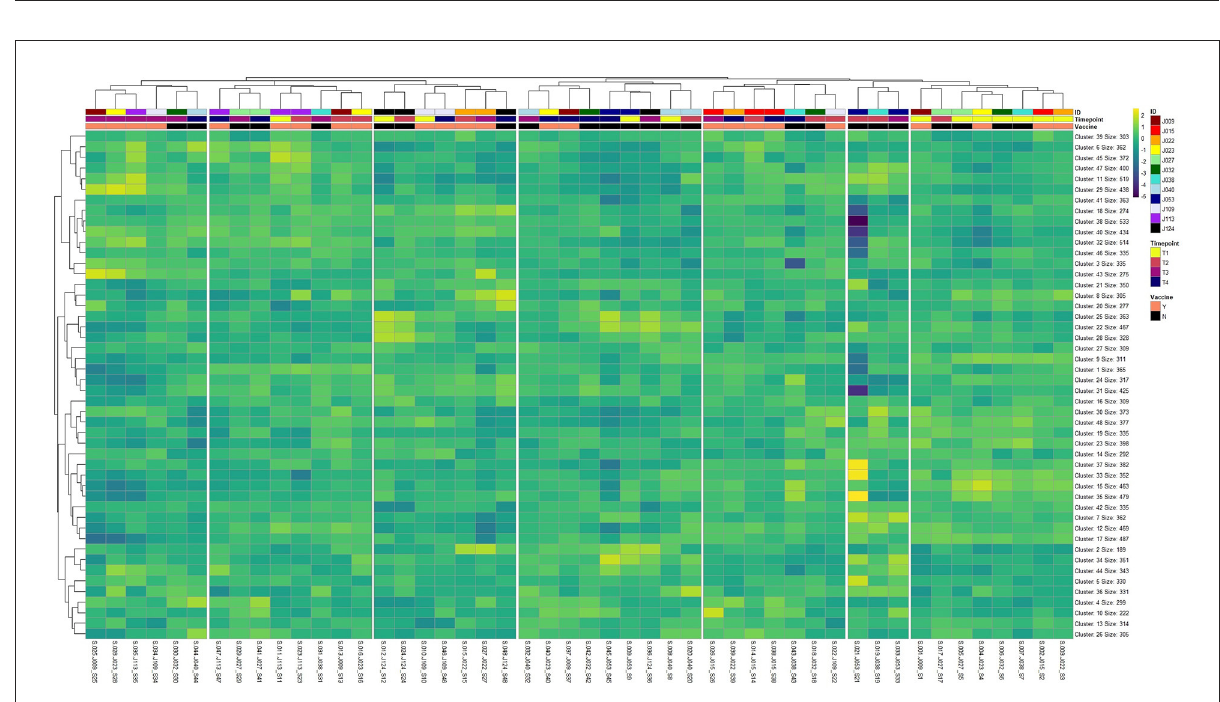
FIGURE2 Heatmap and unsupervised hierarchical clustering analysis of global gene expression patterns across all 48 sample libraries ( n = 17,371) following optimal k-means clustering of genes (k = 48). Gene clusters were labeled by clustering order (Cluster) and the total number of genes embedded within each cluster (Size). Sample libraries were labeled top-to-bottom with individual identification (ID), time point for each sample (Timepoint; T1, T2, T3, and T4), and vaccination group (Vaccine; Yes or